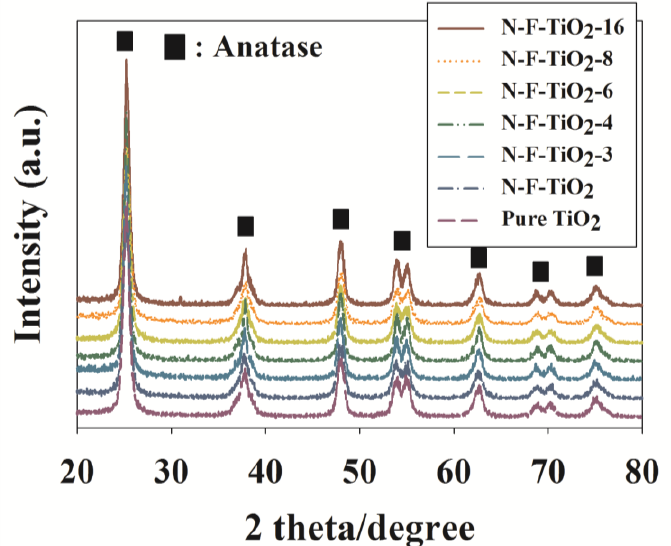
Figure 1. X-ray diffraction patterns of N–F–TiO 2 with different N:F ratios (N–F–TiO 2